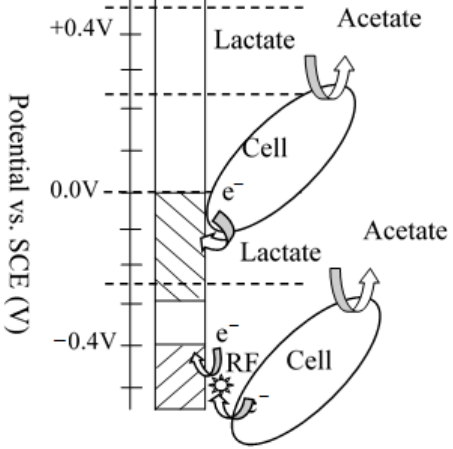
Figure 2. Cartoon diagram of shuttles EET process at different potential windows (mixed zone, cy- tochromes zone and mediator zones separated by dotted lines). cytochromes zone and mediator zones separated by dotted